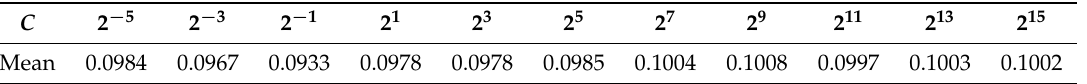
Table 12. Resampled Brier score for the support vector machine model.